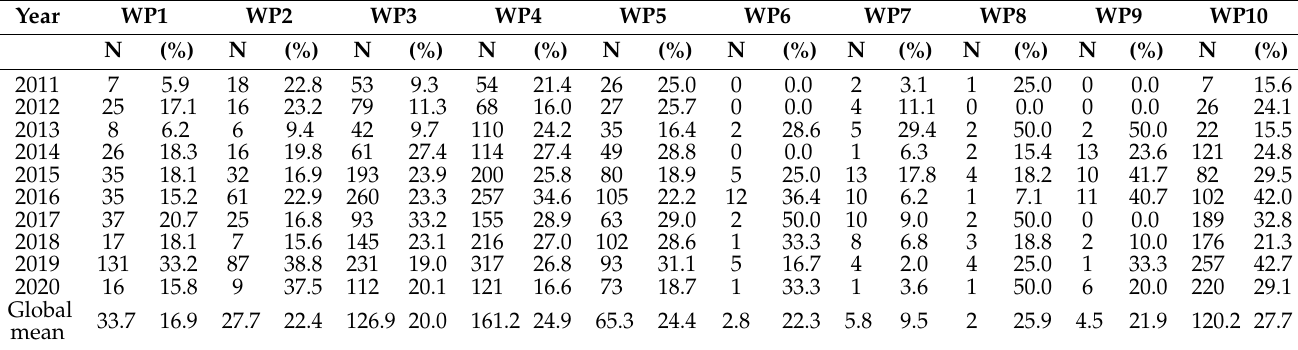
Table 2. Annual recorded positive lightning strikes per wind park presented as actual numbers (N) and as percentage of the total annual strikes (%) (observation period